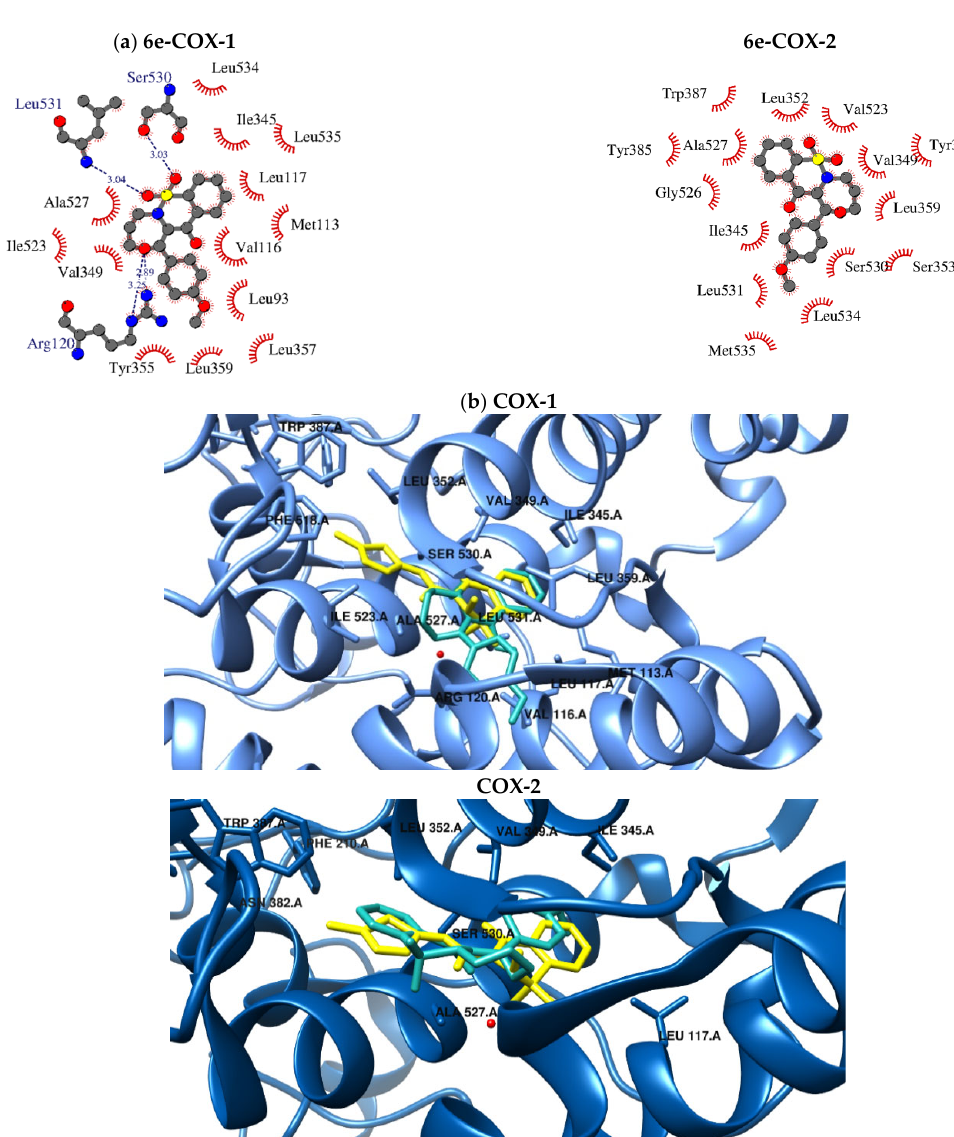
Figure 9. ( a ) The intermolecular interactions (hydrophobic as red arches and hydrogen bonds as navy blue lines). ( b ) Binding mode of compound 6e and meloxicam in the active center of cyclooxygenases (meloxicam is marked in yellow, 6e is green, water molecule is red).